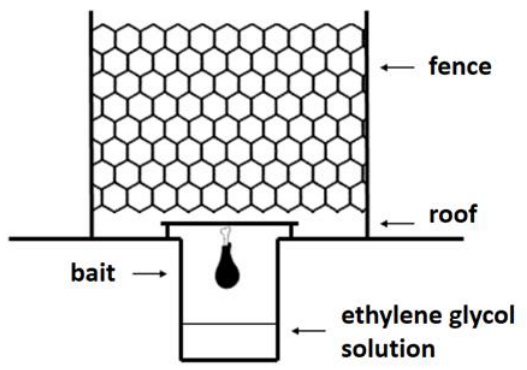
Figure 2. Diagram of the Barber trap used in the study (authors).